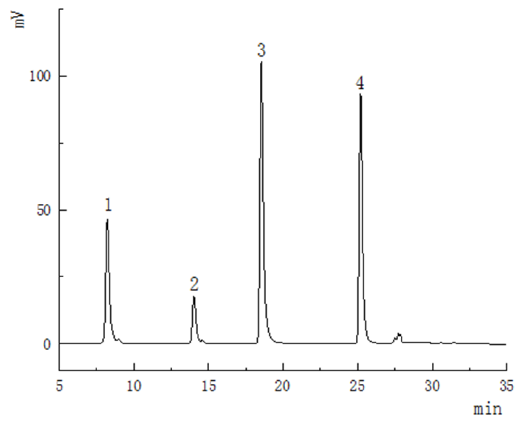
Figure 2. Chromatographic profiles of standard mixture. 1: Dihydromyricetin; 2: Taxifolin; 3: Myricetin; 4: Quercetin.